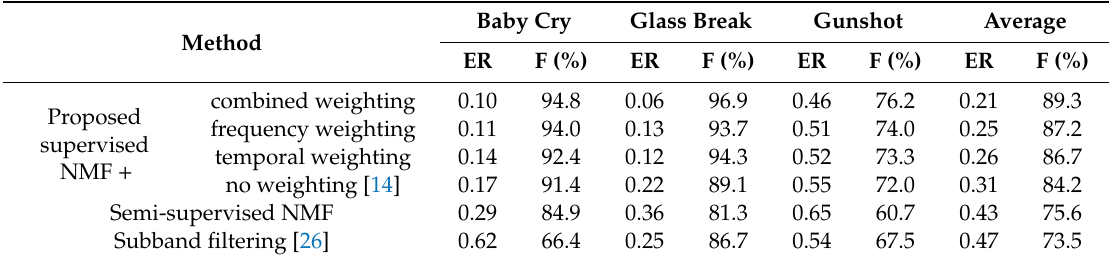
Table 1. Error rate (ER) and F-score (F) results of the proposed method for three event classes on the evaluation